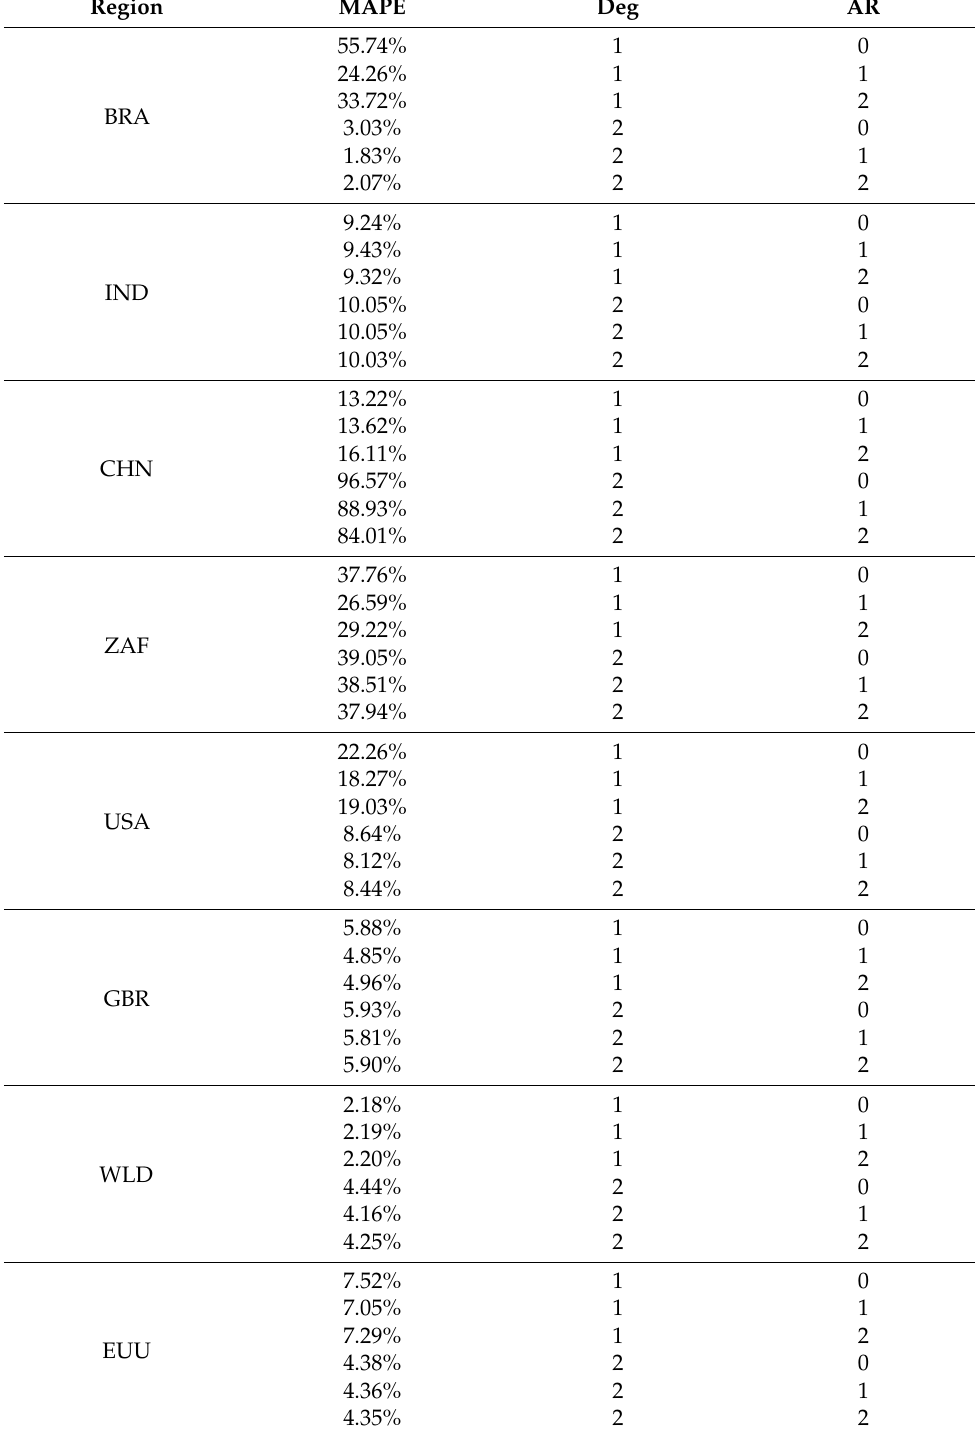
Table 9. Mean absolute percentage error (MAPE) on the test set using ARIMA for different values for the autoregressive ARIMA order (AR), and of the degree of the polynomial (Deg). Region MAPE Deg AR